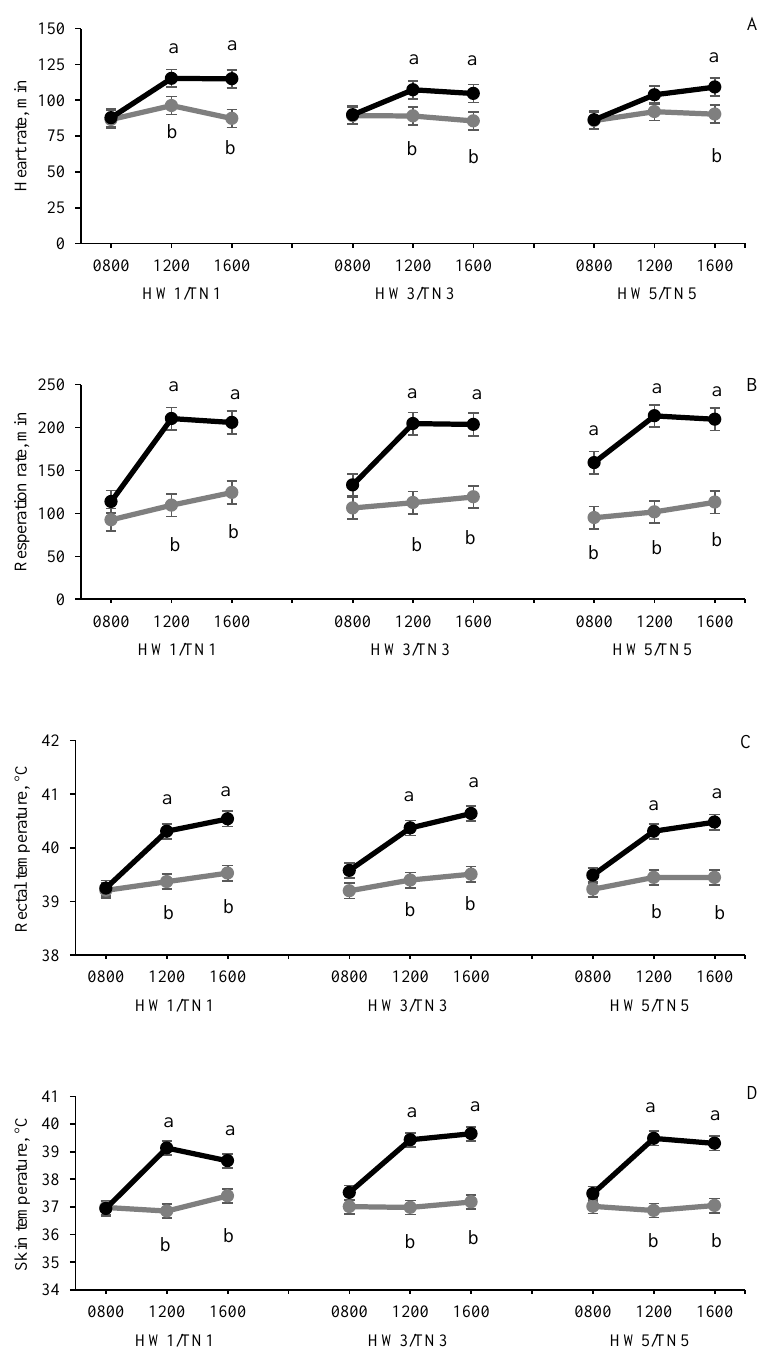
Figure 2. The effect temperature (thermoneutral, TN vs. heatwaves, HW) and heat exposure duration (1 vs. 3 vs. 5 days) have on physiological parameters of second-cross lambs at different times (8:00 h, 12:00 h, 16:00 h) on the last experiment day (Day 5); values are mean ± SED; a and b indicate levels that are significantly different at 5% level of LSD in the same timepoint; HW/TN1–5 = 1 to 5 days HW/TN groups ( n = 12 per group); heart rate, temp. < 0.001; day p = 0.22; temp. × day p = 0.43 respiration rate, temp. p < 0.001; day p = 0.54; temp. × day p = 0.055; rectal temperature, temp. p < 0.001; day p = 0.65; temp. × day p = 0.65; skin temperature, temp. p < 0.001; day p = 0.080; temp. × day p = 0.062. ( A ) Heart rate; ( B ) Respiration rate; ( C ) Rectal temperature; ( D ) Skin